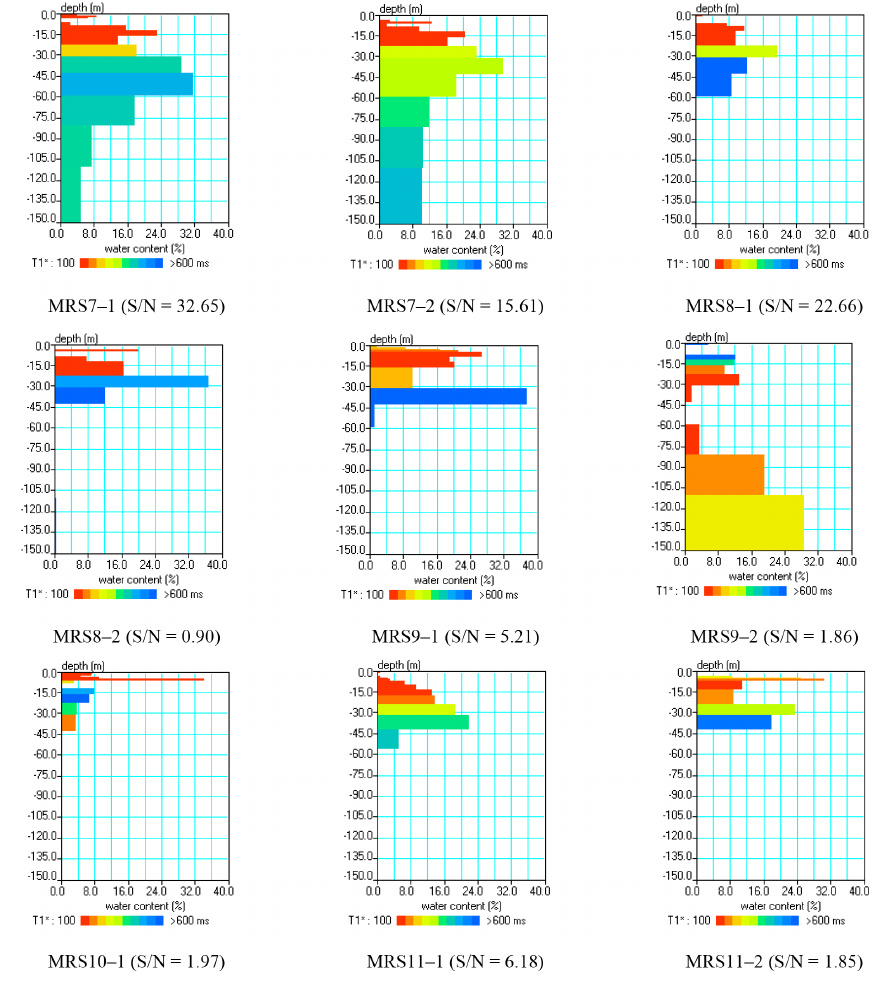
Figure A3. Water content and T 1 derived from MRS measurements.